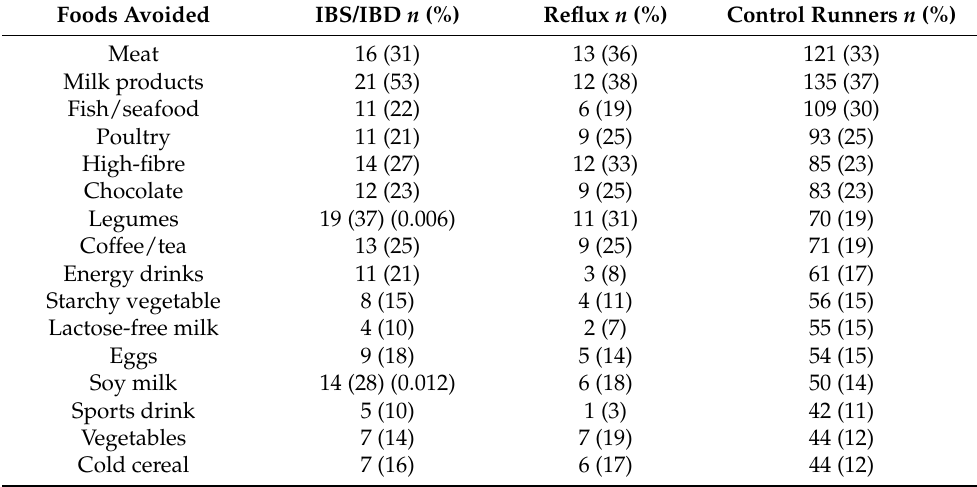
Table 3. Foods Avoided